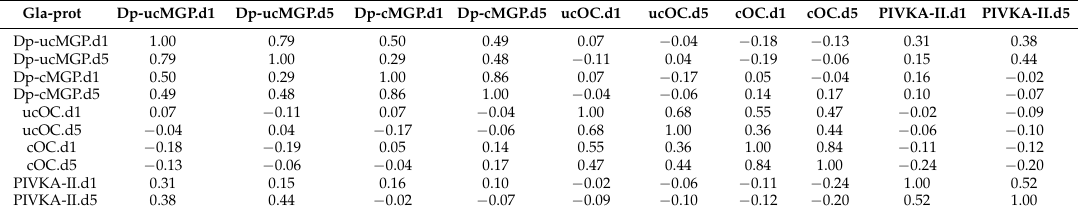
Table 1. Spearman correlations between different Gla-protein (Gla-prot) fractions (d1 = day 1, d5 = day 5, dp-ucMGP = desphospho-uncarboxylated matrix Gla protein, dp-cMGP = desphospho-carboxylated matrix Gla protein, ucOC = uncarboxylated osteocalcin, and cOC = carboxylated osteocalcin). Gla-prot